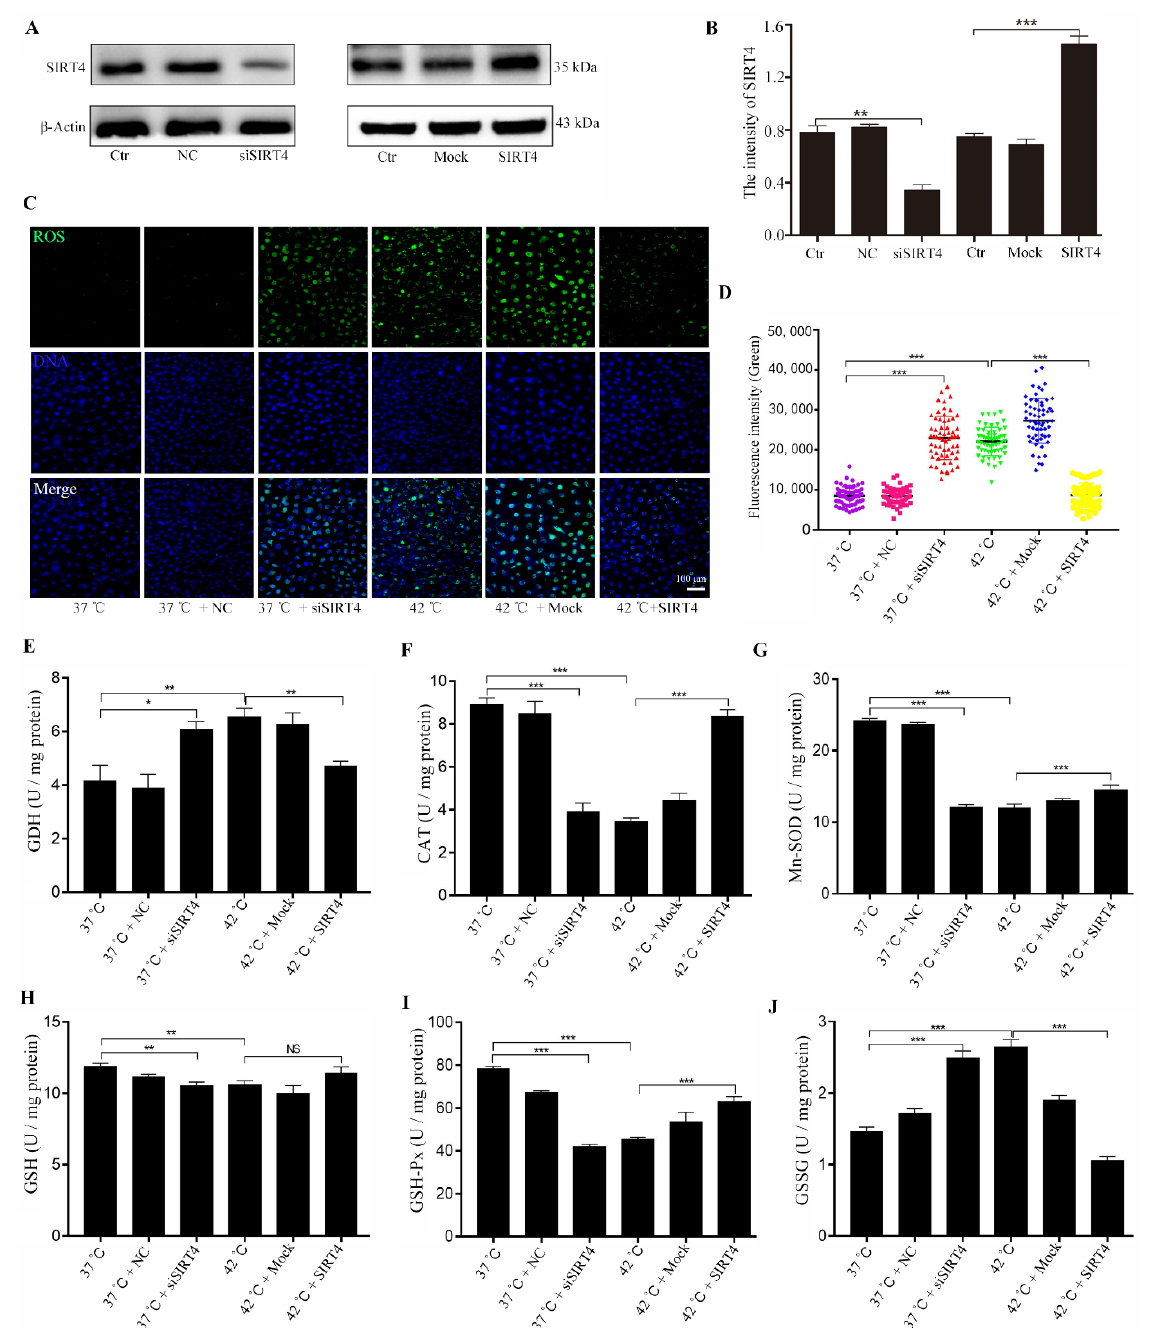
Figure 2. Expression of SIRT4 alleviates oxidative stress of BMECs induced by heat stress. ( A , B ) Western blotting was used to detect expression and knockdown efficiency of SIRT4 in BMECs. ( C , D ) Expression of SIRT4 alleviated heat stress-induced ROS in BMECs. ( E – J ) The activities of CAT, Mn-SOD, and GSH-Px enzymes and the contents of GDH, GSH, and GSSG were detected after expression SIRT4 under heat stress treatment in BMECs. NC: negative control; Mock: expression of control vector. These results are presented as the mean ± SEM from three independent experiments. * p < 0.05, ** p < 0.01, *** p < 0.001.